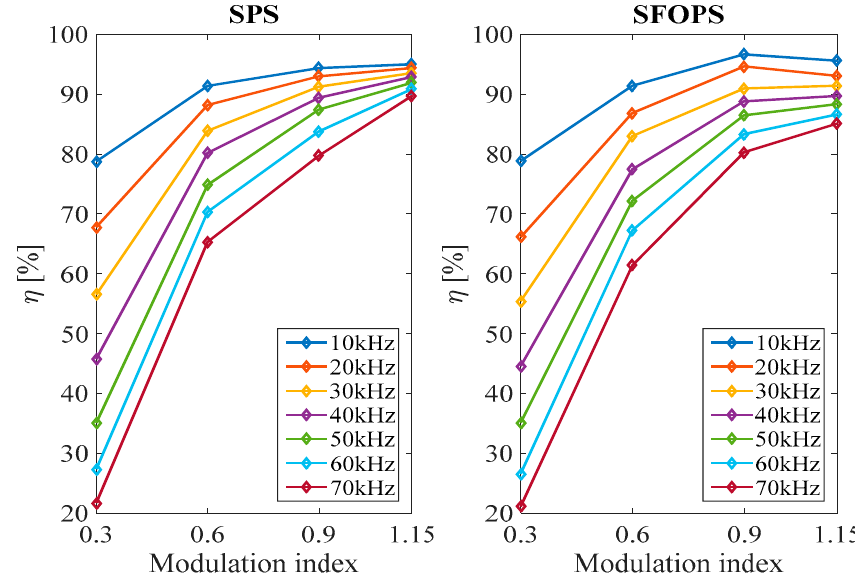
Figure 23. Experimental conversion efficiency trends of SPS and SFOPS schemes.